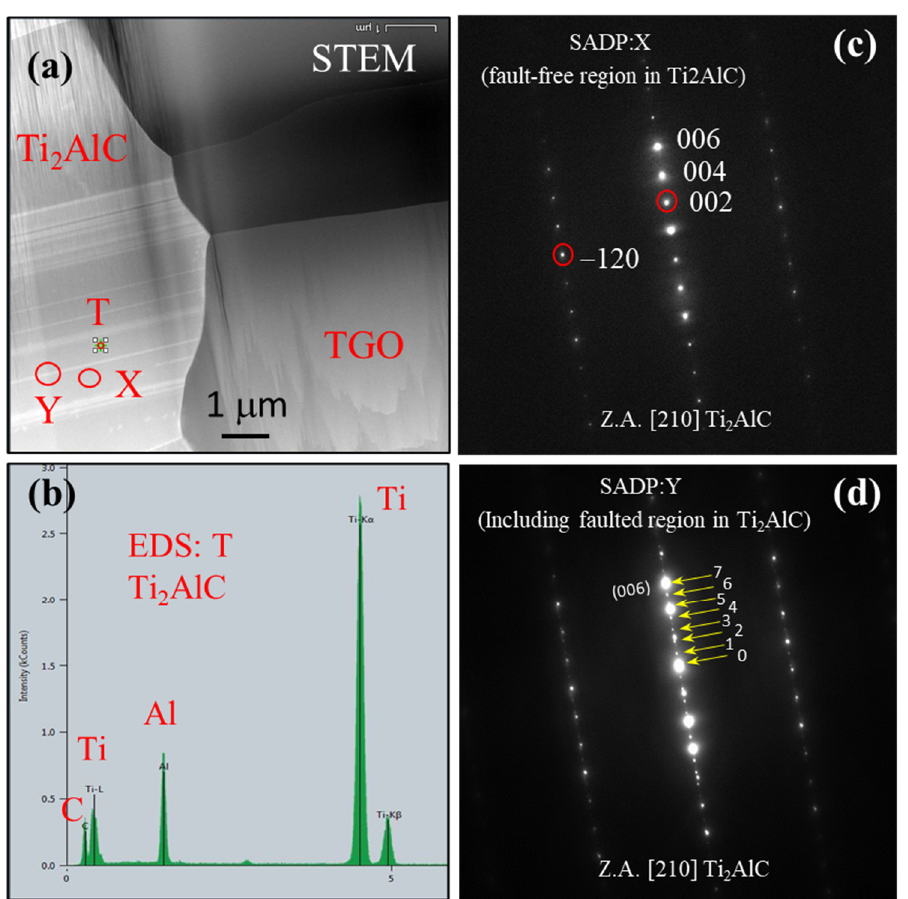
Figure 15. STEM image showing ( a ) the clean, intact Ti 2 AlC—Al 2 O 3 interface, circles mark SADP; ( b ) EDS of the Ti 2 AlC phase (T); ( c ) [210] Z.A SADP of the fault-free region (X), circles mark the primary reflections; and ( d ) extra spots in the SADP of the faulted plane (Y). The fine spots (yellow arrows) are regularly spaced at 1/7 (006), indicating a d-spacing of 7/6 d (001) , with Ti 2 AlC: Hexagonal, a 0 = 3.1 Å, c =1 3.7 Å.